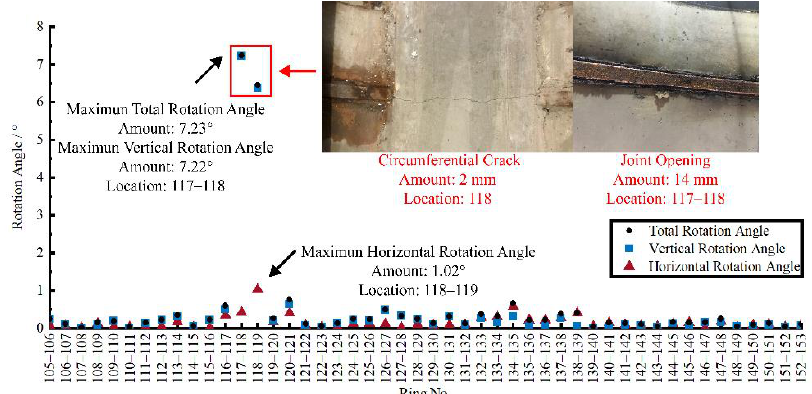
Figure 11. Correlation between the bending deformation and tunnel defect.